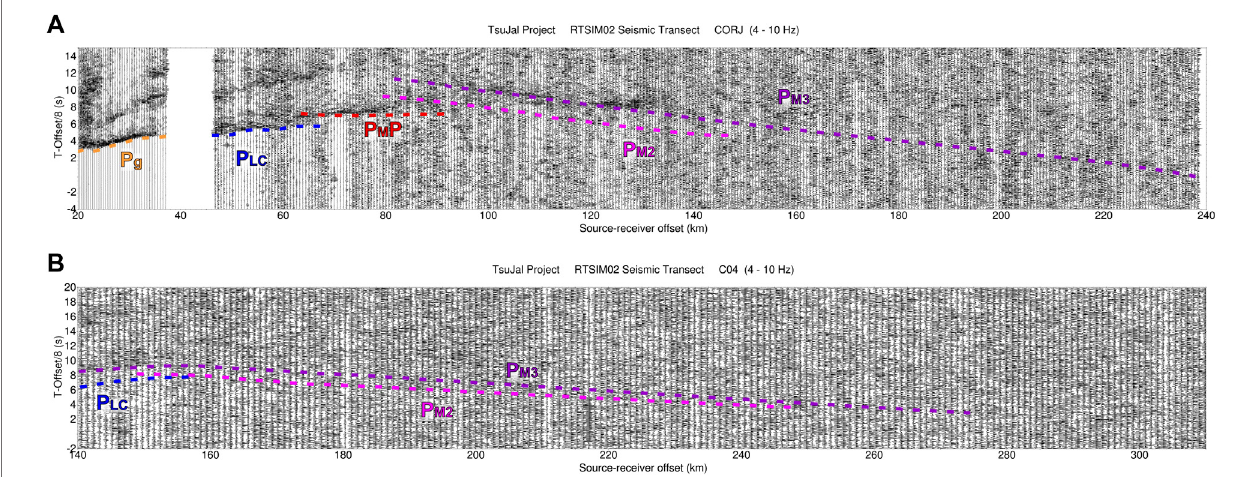
FIGURE 4 | Record sections of the terrestrial seismic stations recording the RTSIM02 seismic transect. Each panel shows the vertical component of the correspondingstationwithareducedvelocity of8 km/s, 4 – 10 Hzband-pass fi lterapplied, trace-normalizedamplitudes, and interpreted re fl ected and refractedP-wave horizons indicated by different color dashed lines. (A) CORJ. (B)